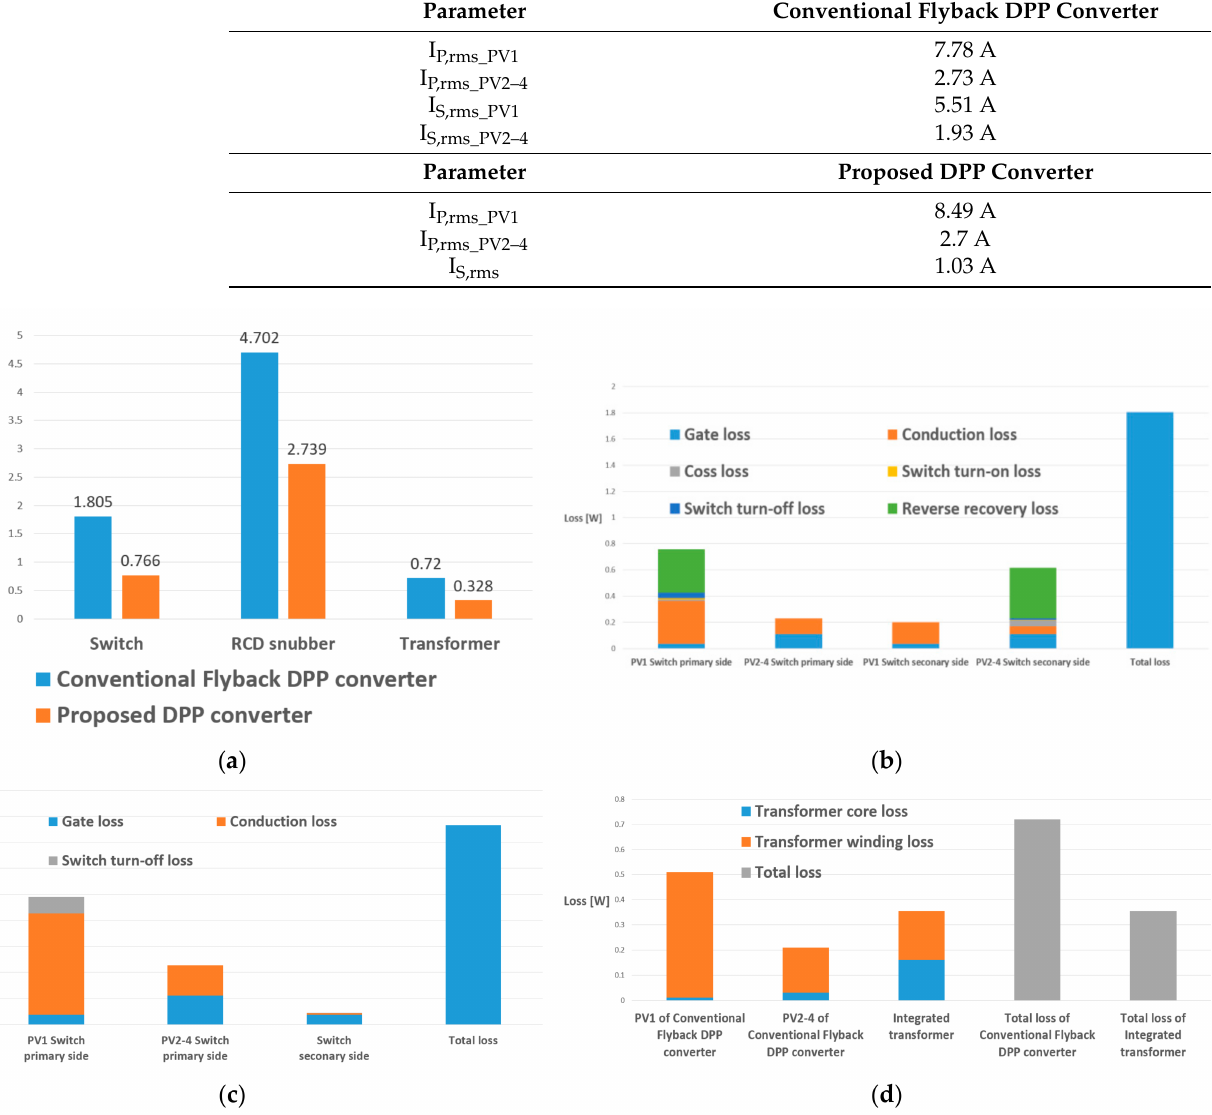
Figure 5. Equivalent circuit for the primary side turned-on state. Table 1. RMS current of primary and secondary side of DPP converter.